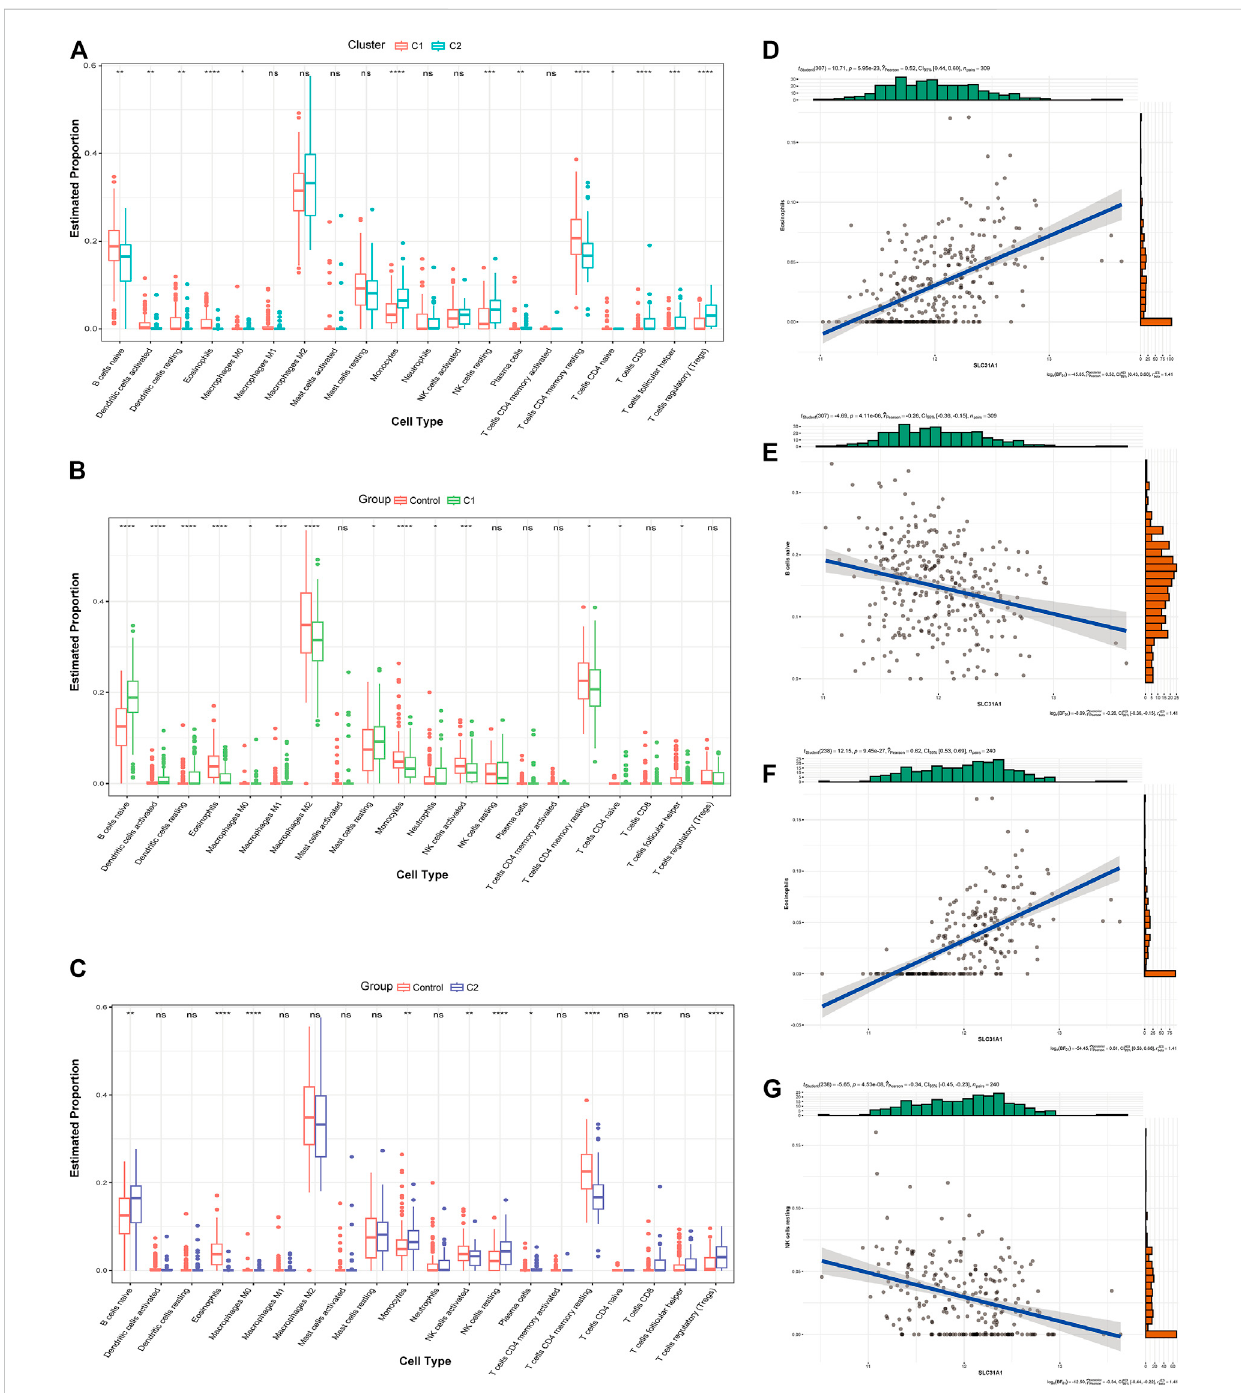
FIGURE 6 Analysis of the immunological pro fi le between the two molecular clusters. (A) Box line plot of immune in fi ltration between two clusters. * p < 0.05, ** p < 0.01*** p < 0.001,**** p < 0.0001,ns,notsigni fi cant. (B) Boxline plotshowingimmune in fi ltration inCRGcluster C1andhealthycontrols. * p < 0.05, ** p < 0.01*** p < 0.001,**** p < 0.0001,ns,notsigni fi cant. (C) Boxlineplotshowingimmunein fi ltrationinCRGclusterC2andhealthycontrols. * p < 0.05, ** p < 0.01 *** p < 0.001, **** p < 0.0001, ns, not signi fi cant. (D, E) Correlation analysis of immune cells with SLC31A1 in CRGcluster C1. (F, G) Correlation analysis of immune cells with SLC31A1 in CRGcluster